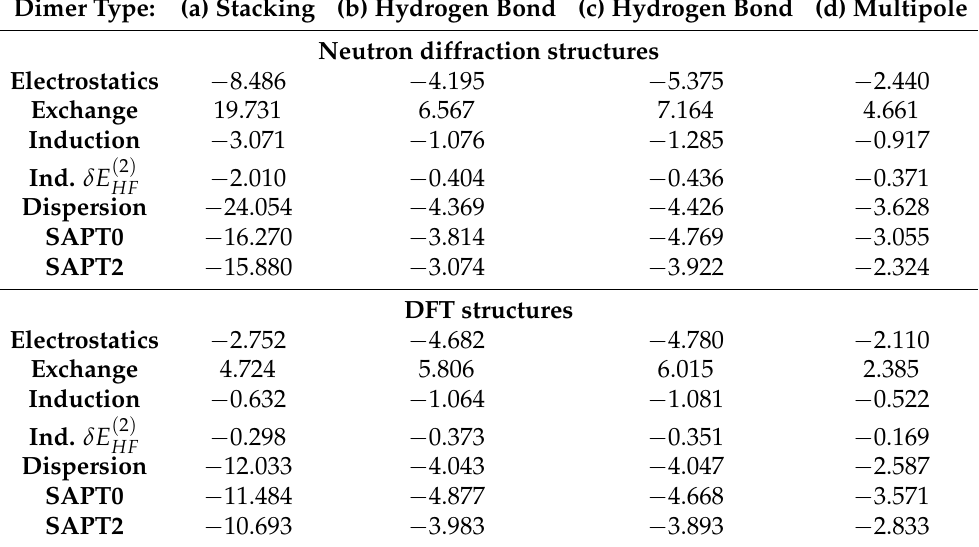
Table 3. The SAPT energy partitioning at the SAPT2 level for the dimers of naphthazarin shown in Figure 7—extracted from the crystal X-ray data [18] (upper part) and reoptimized at the CAM- B3LYP/6-311+G(2d,2p) level of theory (lower part). All energy terms in kcal/mol. SAPT0 and SAPT2 are defined according to Ref.